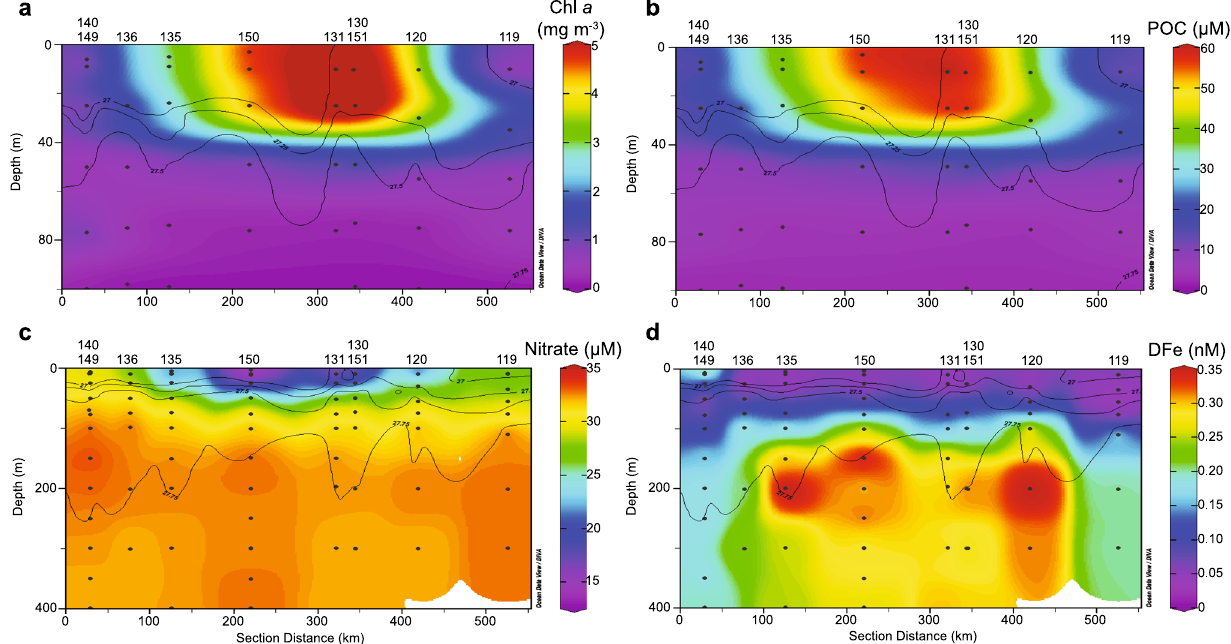
Fig. 2 Biomass and nutrients in the water column in and around the bloom. Vertical sections of a chlorophyll a (Chl a ), b particulate organic carbon (POC), c nitrate, and d dissolved Fe (DFe) from in situ measurements. Note that the depth in panels a and b extends only to 100 m, while the depth in panels c and d extends to 400 m. Station numbers are listed above each section, block dots indicate sampling depths, and black lines show isopycnals. A map of the portion of the cruise shown in these sections and the stations that correspond with the stations here is shown in Fig. 1d. Station 133 is on the map but not included in the